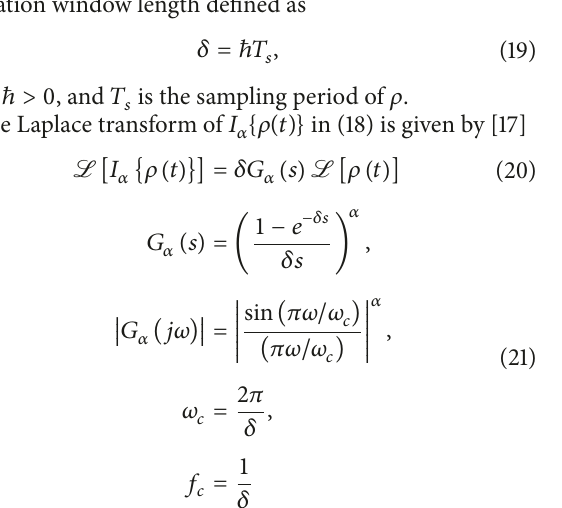
Table 1: Boundary conditions for a shear